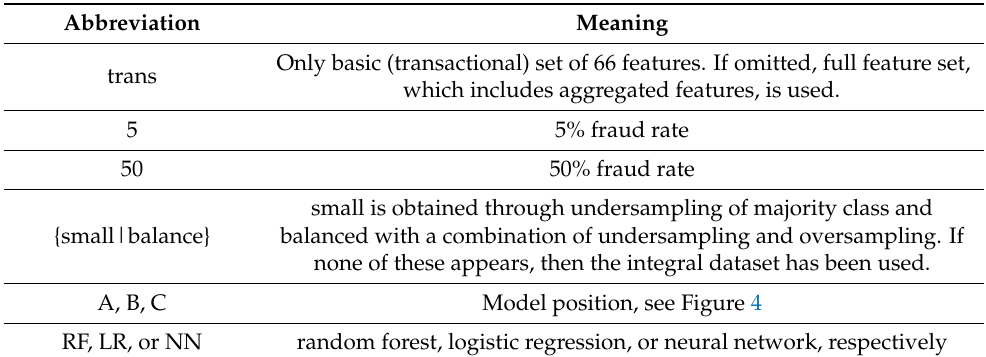
Table 1. Abbreviations used to present experiment